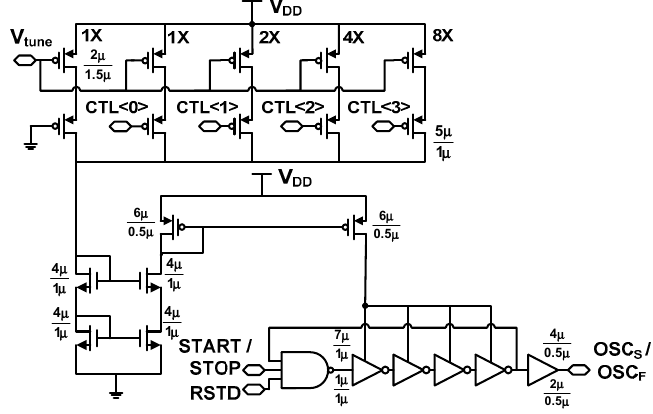
Figure 11. Schematic of the DCO.